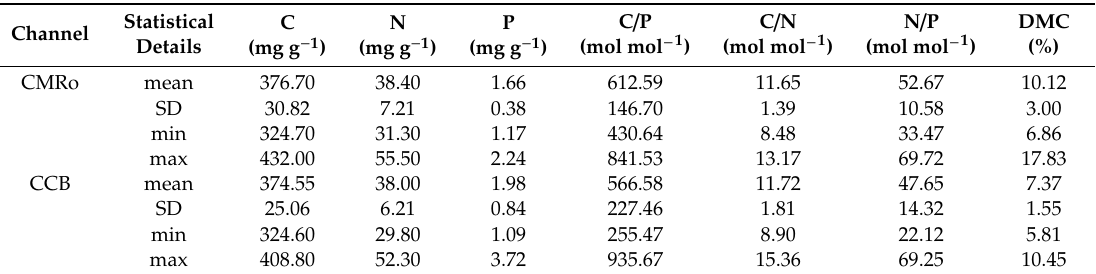
Table 3. Leaf stoichiometry and leaf dry matter content (DMC) of apical shoots (10 cm) taken from two stands of five sections of two navigation channels in Northeast France, the Canal from Champagne to Bourgogne (CCB) and the Canal from the Marne to the Rhine, Western Branch (CMRo).